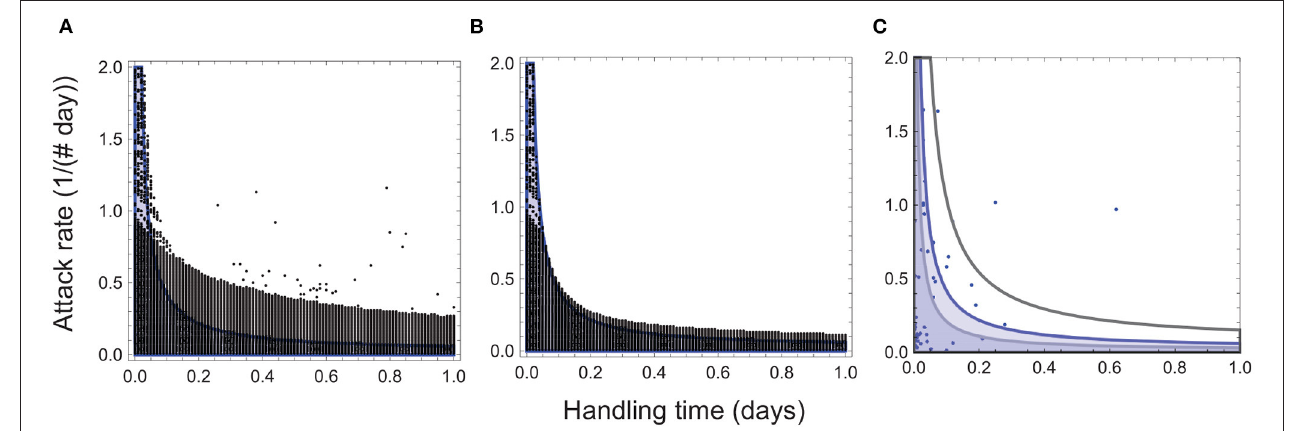
FIGURE 2 | Attack rate-handling time combinations for persistent consumer-resource interactions. The black circles depict the combinations remaining after collapse of interactions with high attack rates and long handling times (A) , and those remaining after collapse and extinction at low abundances (B) . In both panels, the blue curve depicts the stability boundary for the ecological model ( Appendix A ), and the blue shaded region, the attack rate-handling time combinations that yield a stable point equilibrium. The black circles above the blue region represent attack rate-handling time combinations that yield persistent oscillations. No interactions persist in the regions of the parameter space (e.g., high attack rates and long handling times) that leads to high-amplitude oscillations that predispose consumer and resource populations to extinction at low abundances. Parameter values for (A,B) are: r attack rate-handling time combinations, and the black, blue and gray curves depict the stability boundaries for q corresponding to the stability regions depicted in (A,B)